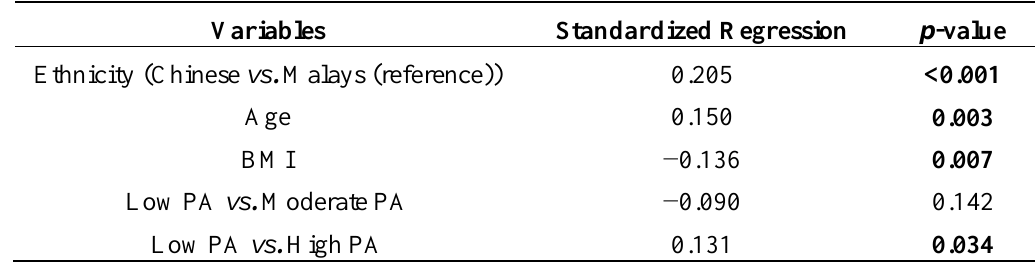
Table 4. The association between the serum 25(OH)D level and its predictors. BMI, body mass index; PA, physical